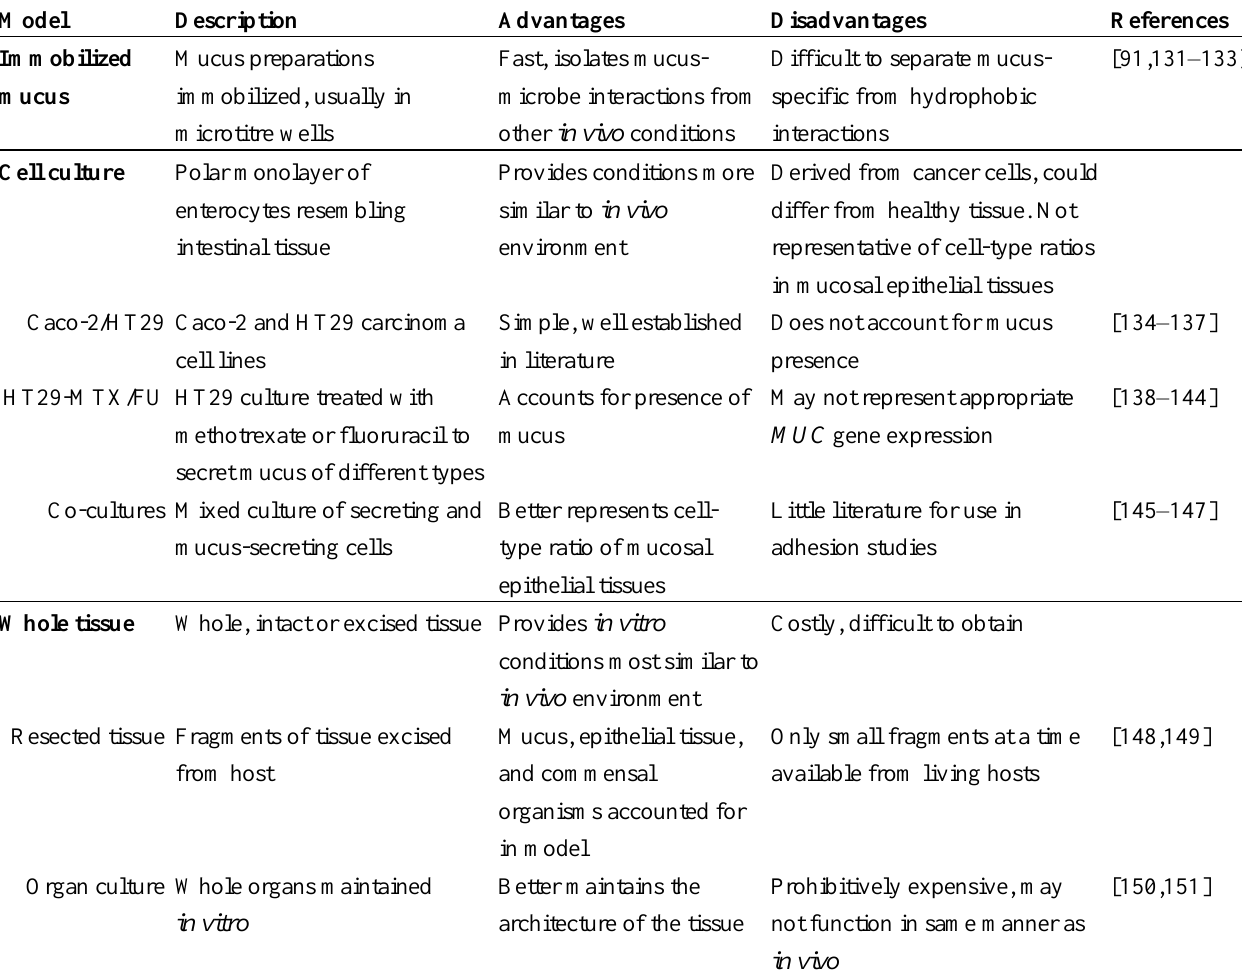
Table 4. Summary of in vitro adhesion